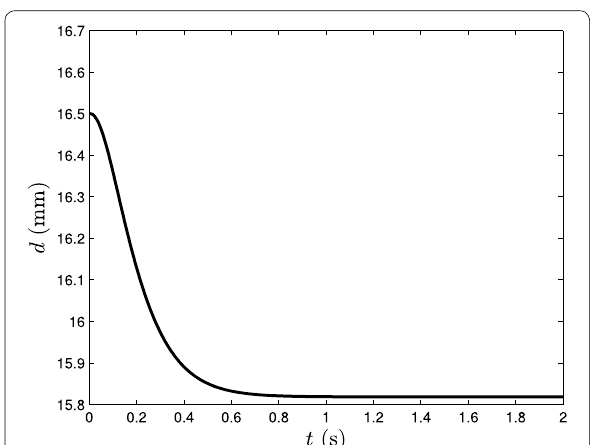
objects on the surfaces with variable friction coefficients.